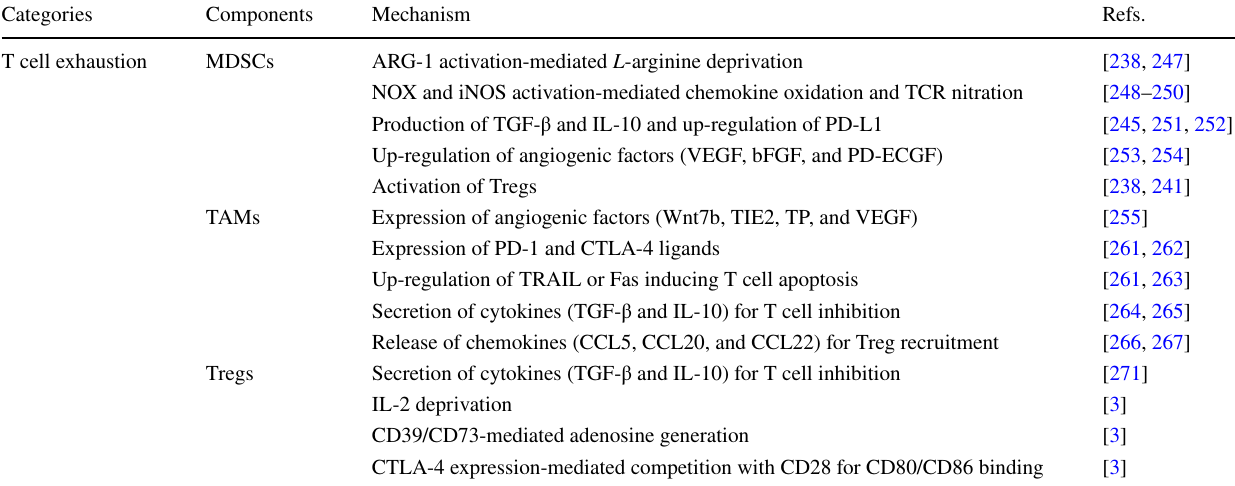
Table 5 Characteristics of T cell exhaustion in cold tumors